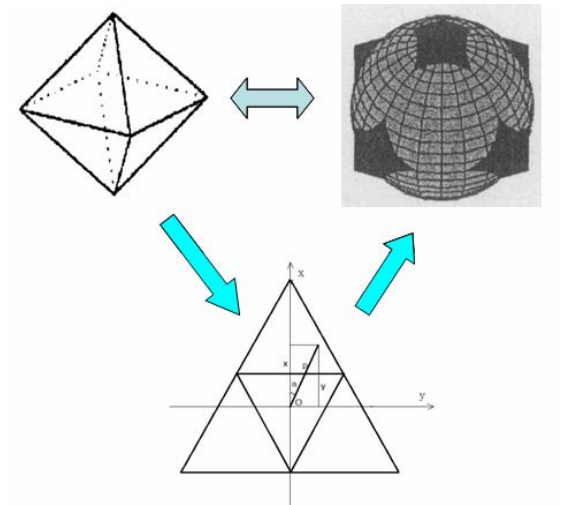
Figure2 The process of coordinate transformation Plane coordinate to sphere